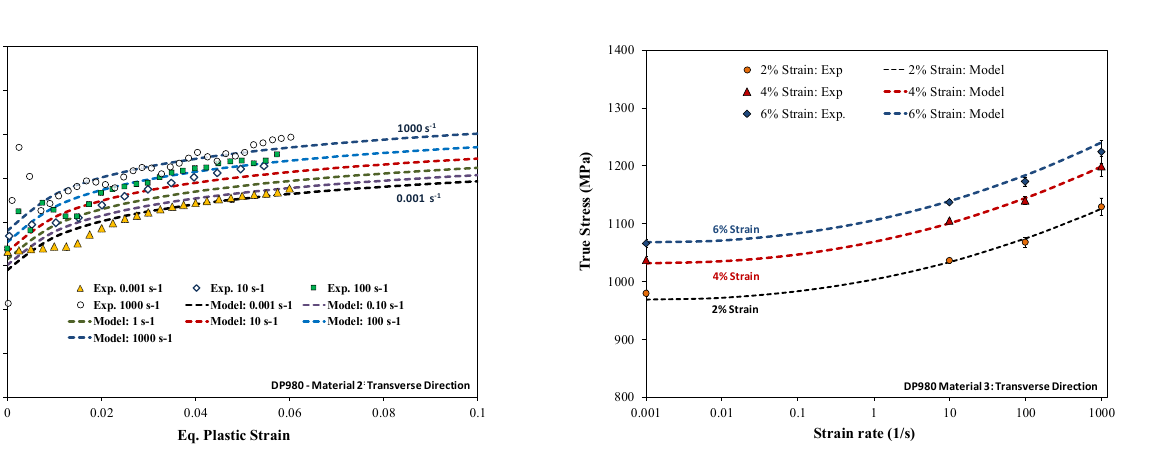
Fig. 20. Experimental rate sensitivity of Material 3 compared to the CS model